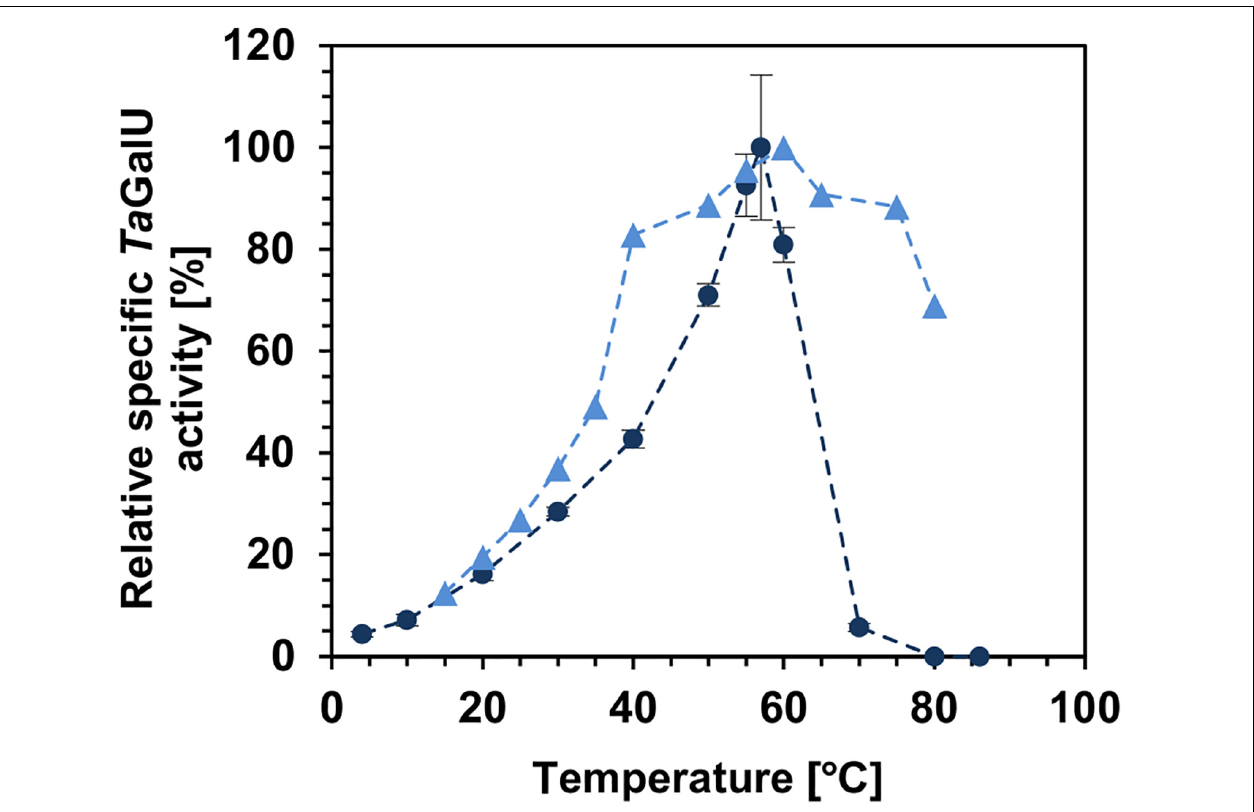
FIGURE 5 | Relative specific Ta GalU activity of the free and immobilized enzyme depending on the reaction temperature. Free enzyme (dark blue dots): Reaction conditions are 2 mM UTP, 2 mM G1P, 4 mM MgCl 2 , 50 mM Hepes buffer, pH 7.0, 0.013 µ g mL − 1 free Ta GalU, 0–86 ◦ C in 1 mL reaction volume. 100% relative specific activity corresponds to 1430 U mg − 1 . Means with standard deviations of triplicate measurements are shown. Immobilized enzyme (blue triangles): Reaction conditions are 2 mM UTP, 2 mM G1P, 4 mM MgCl 2 , 50 mM Hepes buffer, pH 7.0, 0.3109 µ g mL − 1 Ta GalU immobilized amino modified MCF, 15–80 ◦ C in 3 mL reaction volume. No replicates for immobilized enzyme presented, but were performed for 30 ◦ C, 40 ◦ and 50 ◦ with a standard deviation lower than 5%. The highest activities of free and immobilized Ta GalU were set as